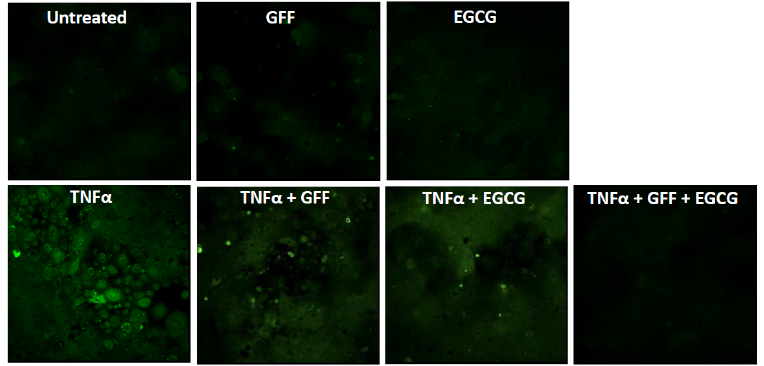
Figure 5. Synergistic antioxidant activity of Galactomyces ferment filtrate (GFF; 0.1%) and epigallocatechin gallate (EGCG; 10 μ M). Reactive oxygen species (ROS) are visualized with dichloro-dihydro-fluorescein diacetate staining (green). The production of ROS is very slight in the human keratinocytes treated with medium control (untreated), a low concentration of GFF, or a low concentration of EGCG. Tumor necrosis factor α (TNF α ) induces ROS production, which is weakly inhibited by a low concentration of either GFF (TNF α + GFF) or EGCG (TNF α + EGCG). The ROS production by TNF α is markedly downregulated by the simultaneous addition of GFF and EGCG (TNF α + GFF +